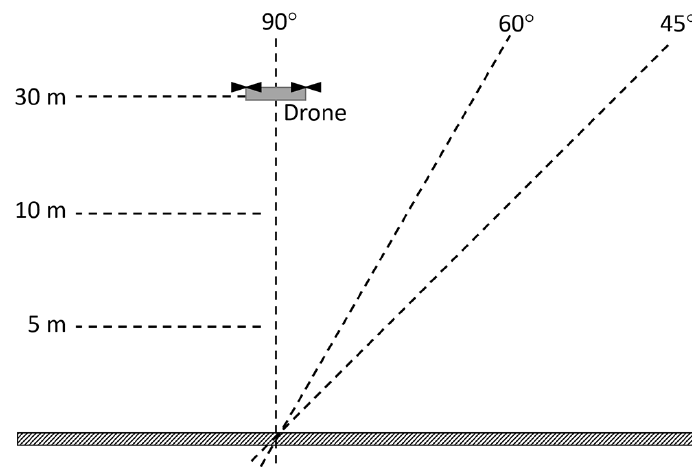
Figure 4. Hover test UAV positions. Table 4. Hover tests L Aeq (dB (A)) as a function of distance and angle.